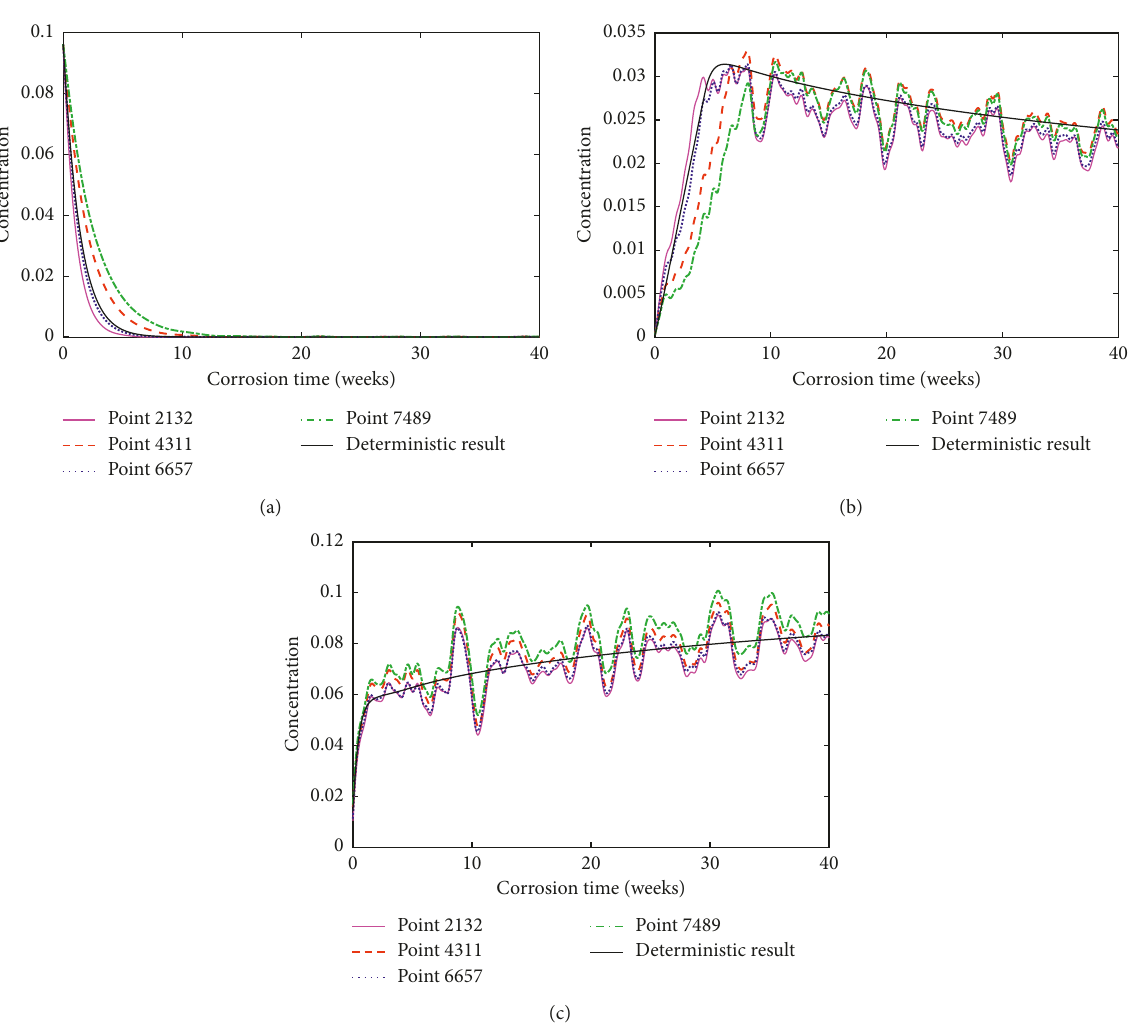
Figure 6: Samples of the concentration evolutions of (a) calcium hydroxide, (b) gypsum, and (c) ettringite.